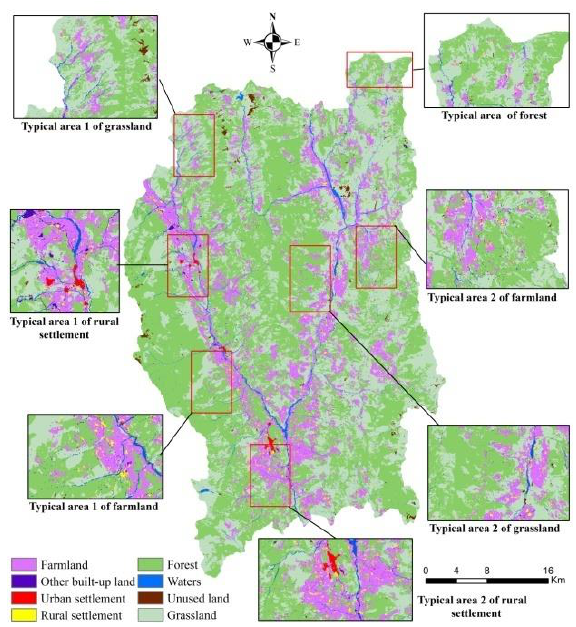
Figure 11. Spatial distribution of land use under the optimized scenario in 2030.